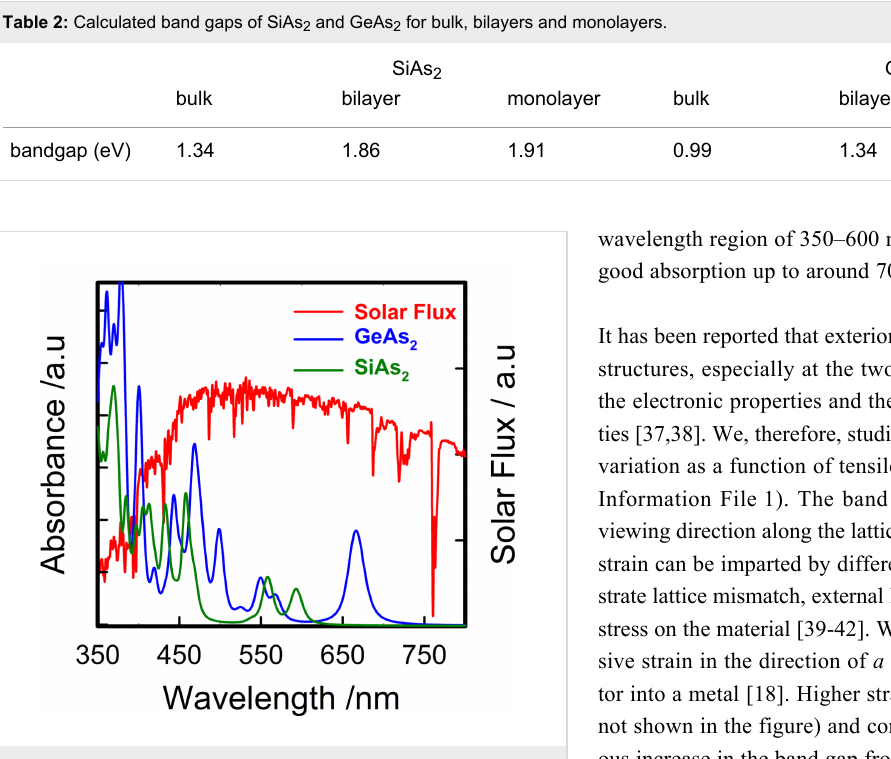
Figure 4: Calculated light absorption spectrum of monolayers of SiAs 2 (green) and GeAs 2 (blue) using HSE functional superimposed to the incident AM1.5G solar